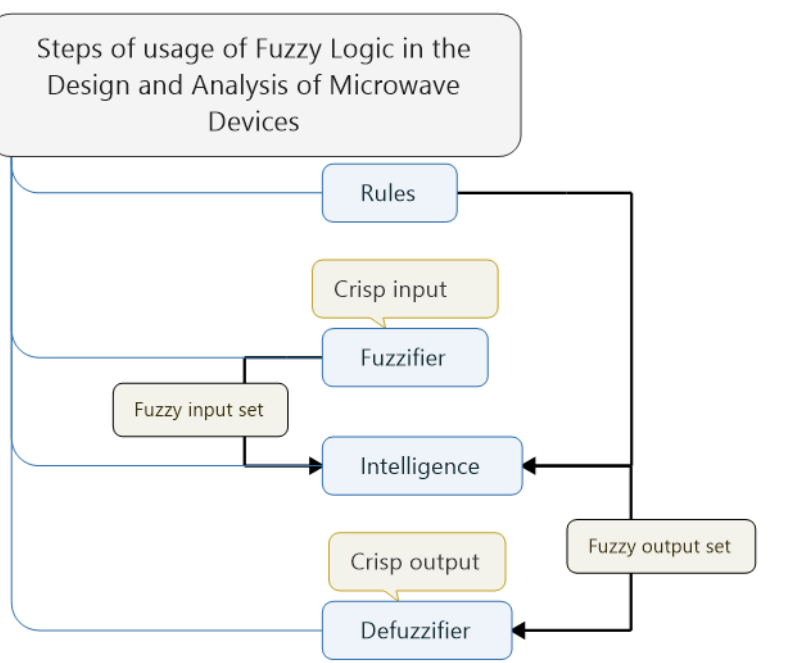
Figure 4. Steps of the usage of fuzzy logic in the design and analysis of microwave